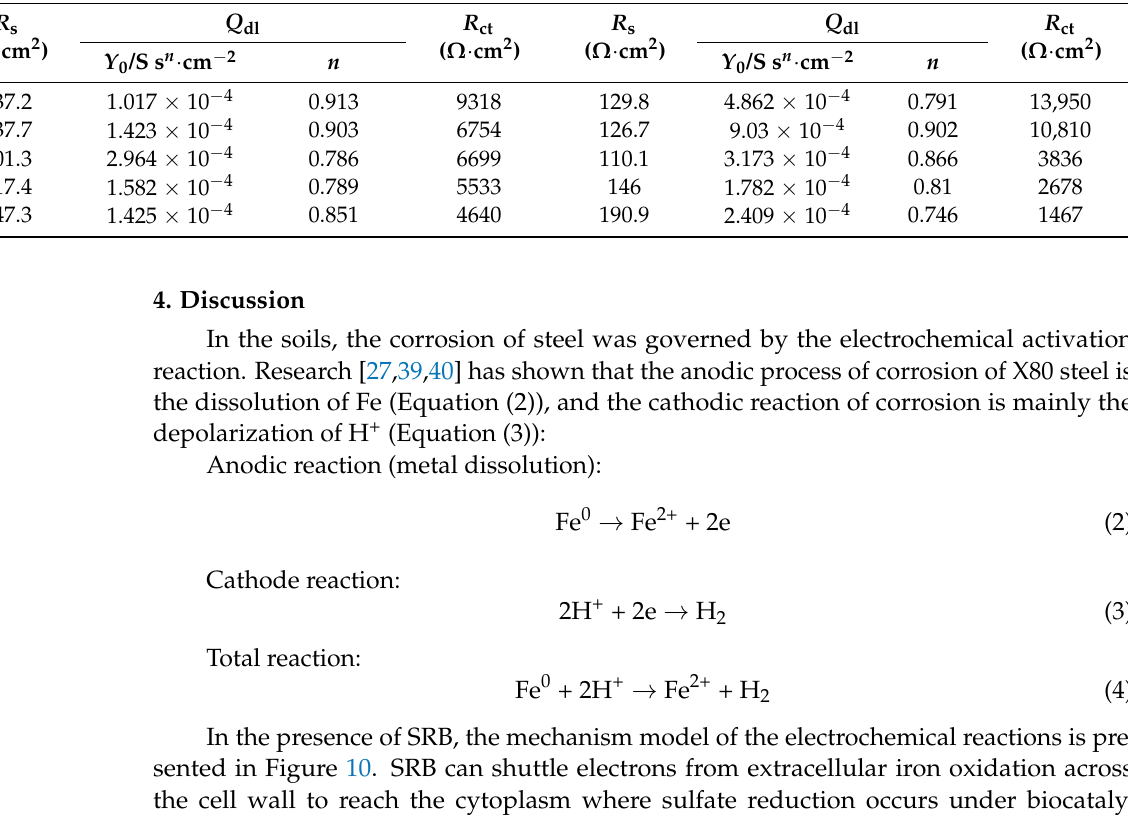
Figure 9. Electrochemical equivalent circuits used to fit the EIS data in this work. Table 4. Fitted parameters for the Nyquist plots in the abiotic and inoculated solutions. Sterile